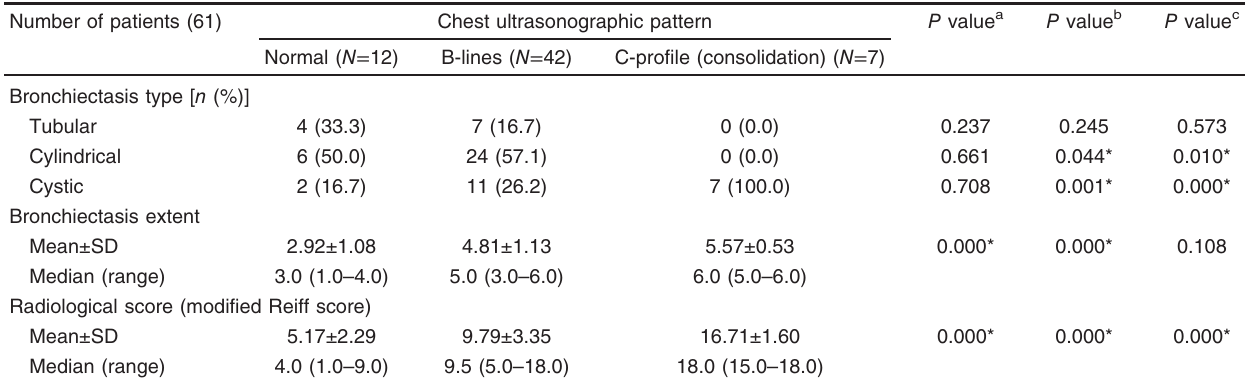
Table 2 Correlation between chest ultrasound and high-resolution computed tomography in patients with bronchiectasis Number of patients (61) Chest ultrasonographic